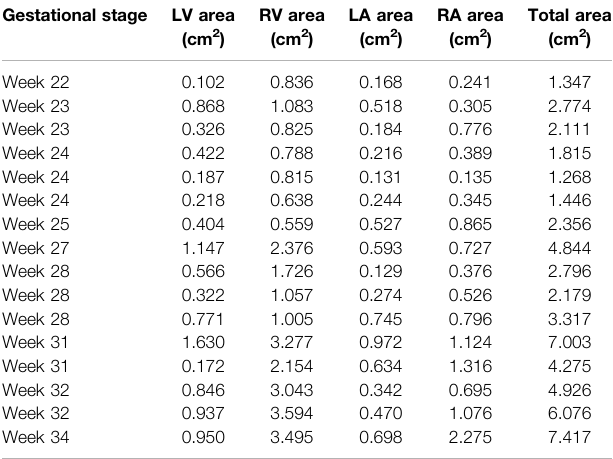
TABLE3| Cross-sectionalareasoftheheartchambersforHLHSheartsatvarious gestational